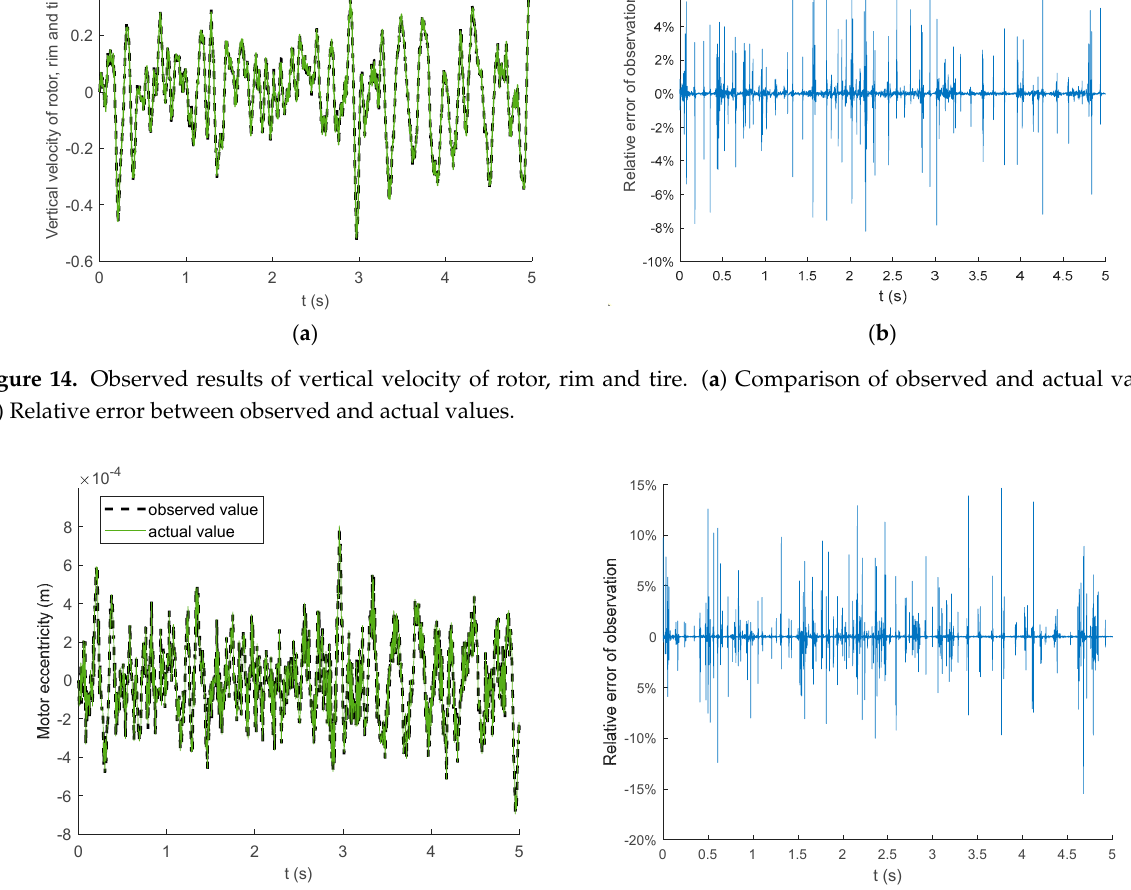
Figure 15. Observed results of motor eccentricity. ( a ) Comparison of observed and actual values. ( b ) Relative error between observed and actual values.